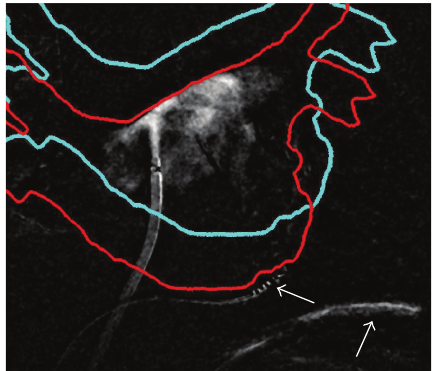
Figure 2: A correct (red) and wrong (cyan) registration result. In both cases, the contrasted area is fully inside the projection shadow represented by the colored outlines. Both registration results lead to a similar NCC value when using an area-based feature for automatic registration. Note that motion artifacts could be kept to a minimum thanks to the best reference frame selection. Only some residual artifacts remained in the vicinity of the moving coronary sinus (CS) catheter and the diaphragm; see white